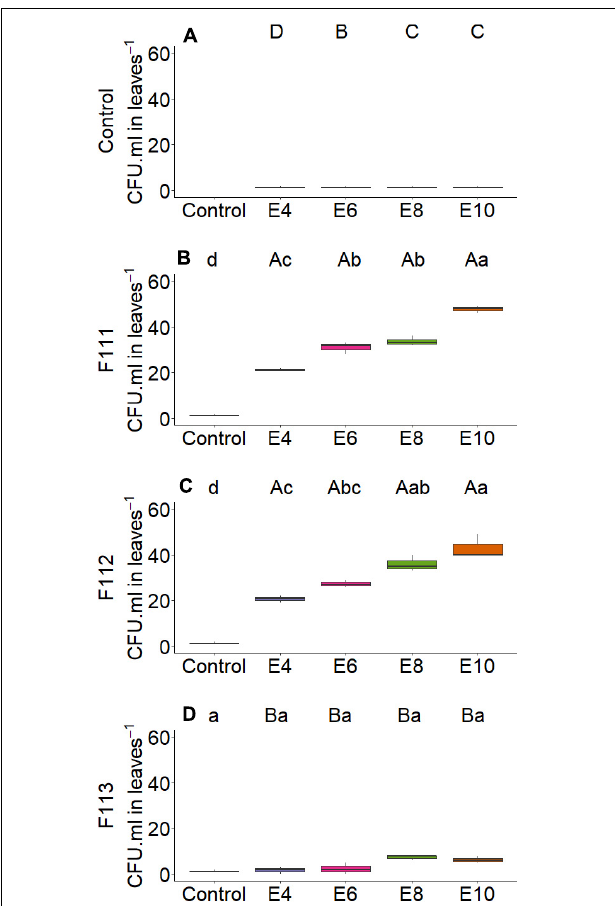
FIGURE 7 | Boxplots (median and quartiles) of CFU in cotton leaves inoculated with (A) Aspergillus brasiliensis (B) , Aspergillus sydowii (C) , and Aspergillus sp. (D) in four concentrations. Different lowercase letters in a row and uppercase letters in a column indicate statistical difference between means (Tukey, p < 0.05). F111, Aspergillus brasiliensis ; F112, A. sydowii ; F113, Aspergillus sp.; E4, 1 × 10 4 ; E6, 1 × 10 6 ; E8, 1 × 10 8 ; E10, 1 × 10 10 conidia or CFU mL − 1 ; Ctrl, control; and CFU, colony-forming units.